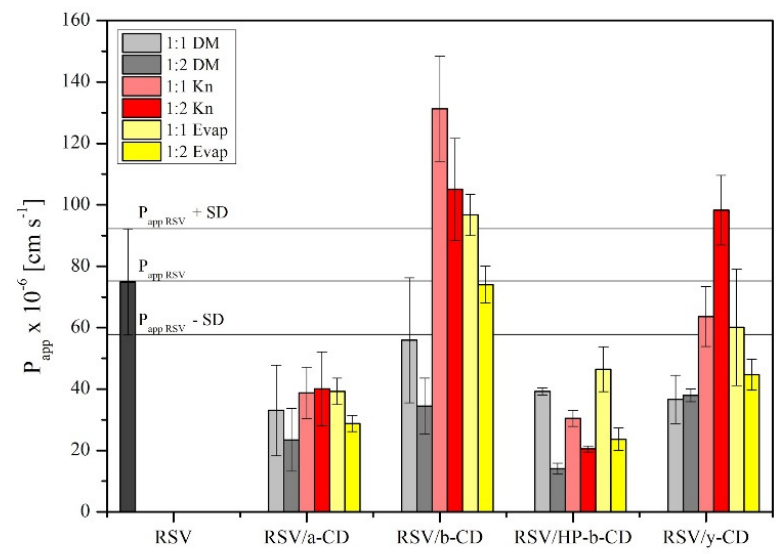
Figure 5. The permeability values of pure RSV and its CDs systems. 440